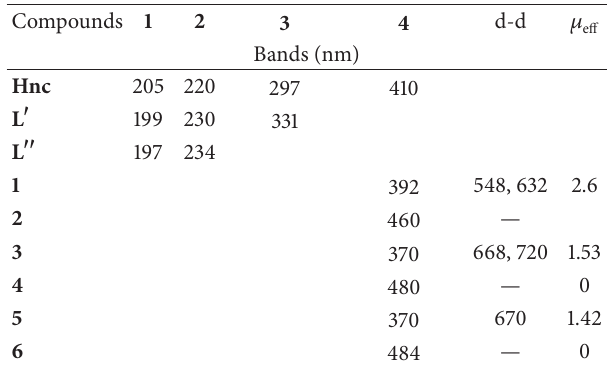
Table 2: Electronic spectra bands (nm) for the ligands and com-